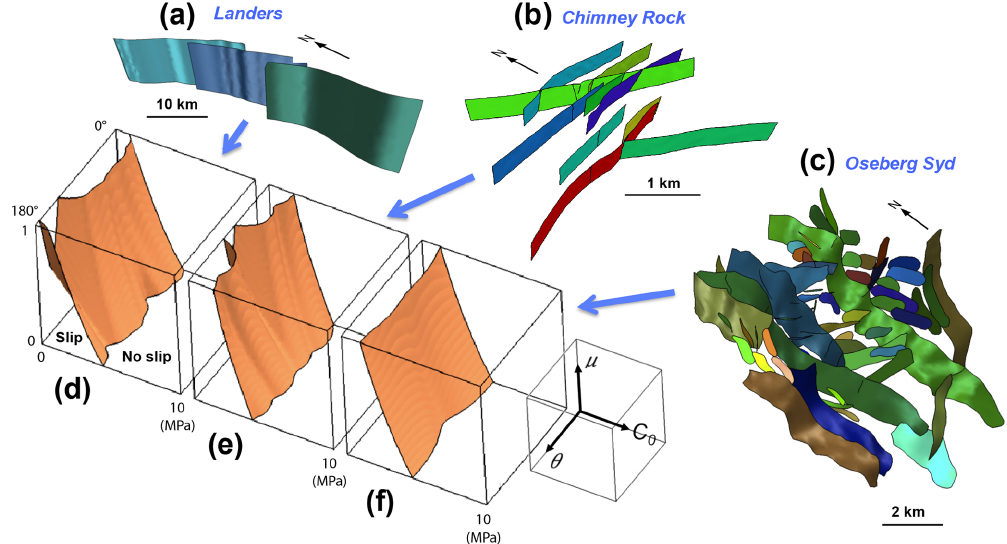
Figure 3. Examples of 3-D fault system geometry from a simple to a very complex case, and related fault slip envelopes. (a) The Landers strike-slip fault segments. (b) The Chimney Rock conjugate strike-slip fault system. (c) The Oseberg Syd normal fault system. Panels (d) , (e) , and (f) are fault slip envelopes for each fault system, defining fault system stability for variable uniaxial stress orientation ( θ ), static friction ( µ ), and cohesion ( C 0 ) on fault surfaces. Colors in (a) , (b) , and (c) correspond to different fault surfaces and allow an individual fault to be